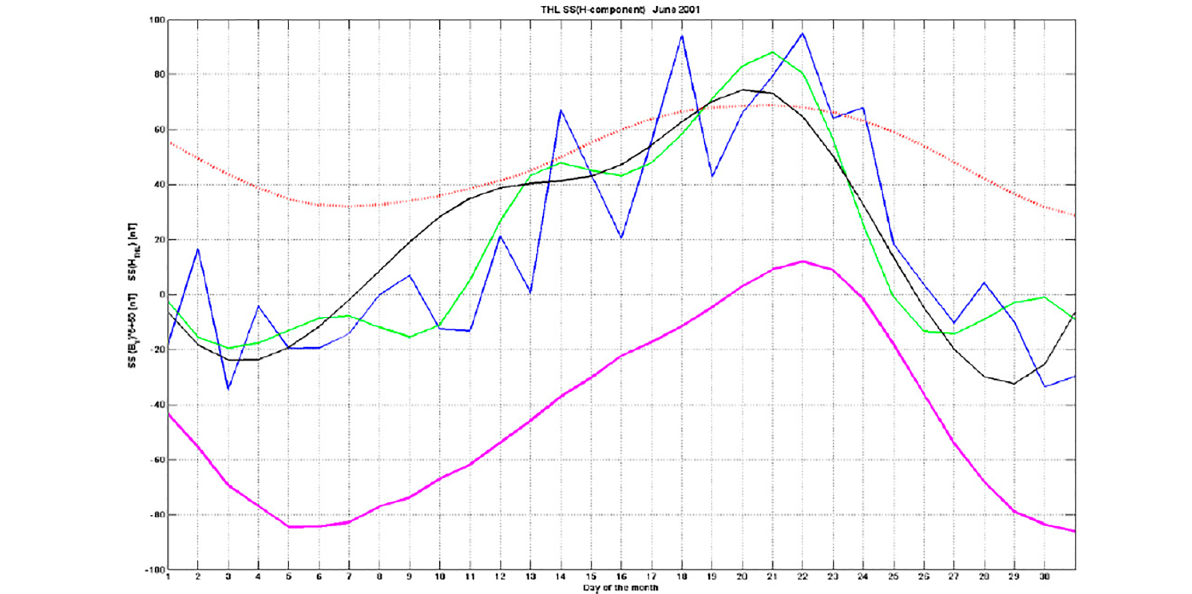
Figure A1. Reproduction of Fig. 6b from Janzhura and Troshichev (2011) referred to in the present Sects. 3 and